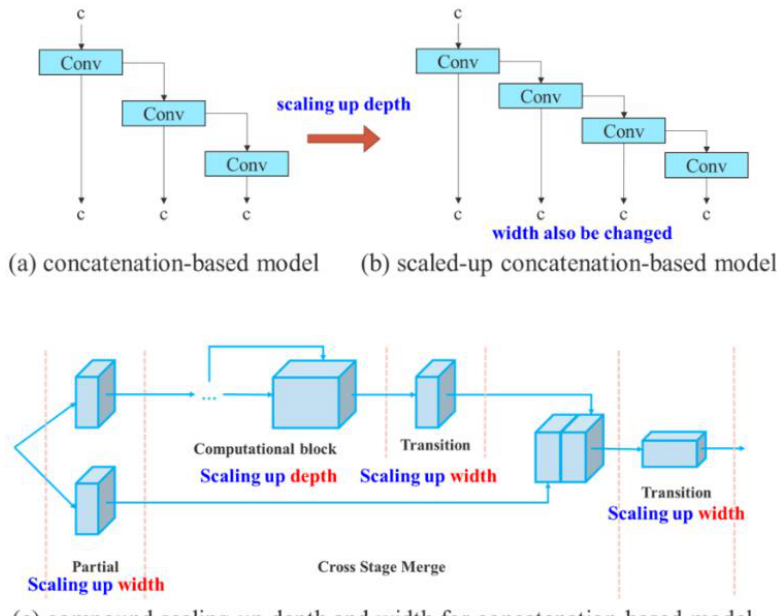
Figure 2. Working of YOLOv7: compound model scaling [21].